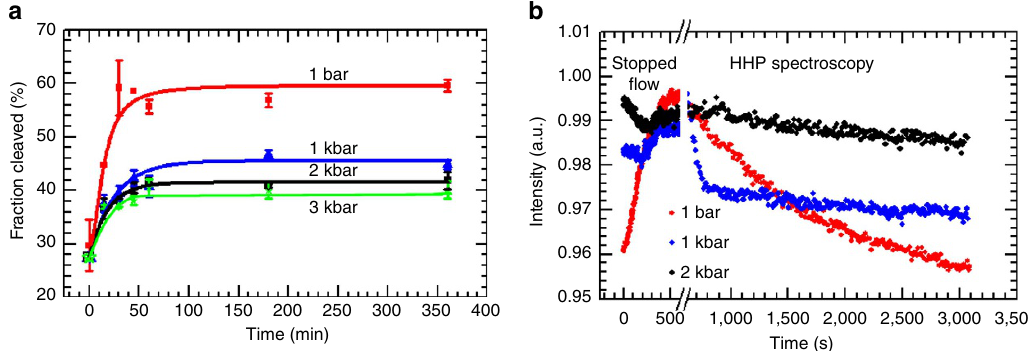
Figure 3 | Pressure dependence of the self-cleavage reaction. ( a ) Time evolution of 3.6 m M wt-HpRz self-cleavage reaction (fraction of cleaved RNA after addition of 6mM Mg 2 þ ) at different pressures: ambient pressure (1 bar), 1, 2 and 3kbar (1kbar ¼ 100MPa). Solution conditions: 50mM Tris-HCl buffer, 0.1mM EDTA, pH 7.5, 6mM MgCl 2 , T ¼ 10 (cid:2) C. Error bars represent standard deviation of three independent measurements. ( b ) Effect of pressure on the docking/cleavage reaction, combining the rapid stopped-flow (up to 550s) and slower (from 600 up to 3,000s) kinetic FRET data of the Cy3/Cy5 fluorescently labelled HpRz at ambient pressure (red), 1kbar (blue) and 2kbar (black). The initial rise of the FRETsignal is due to the shift of the docking- undocking equilibrium of the uncleaved ribozyme to the docked state, whereas the subsequent decay is due to the cleavage reaction and undocking/